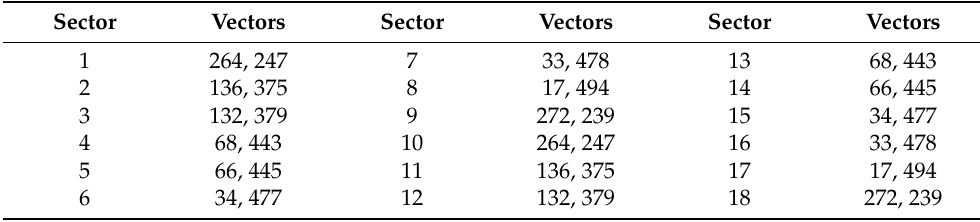
Table 4. Selected Zero Vector of AZS